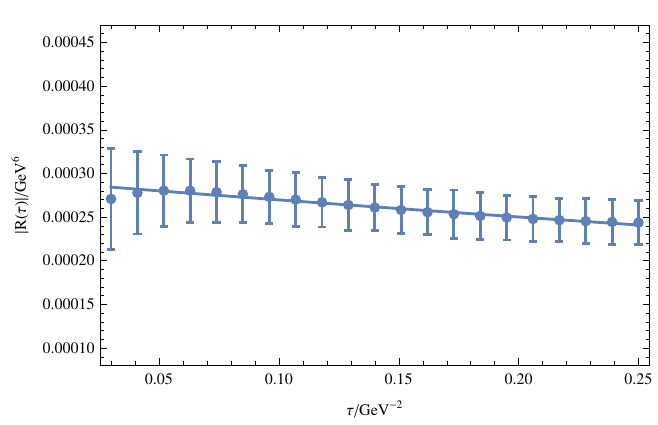
Figure 6 . QCDSR minimum- (cid:31) 2 (cid:12)t for the (cid:22) uu + (cid:22) dd and glueball mixed state: the dots represent QCD side of the master equation (2.9), and the middle line represents phenomenological side of (2.9). The error bars are induced by 10% uncertainty of the phenomenological parameters in of the phenomenological parameters of table